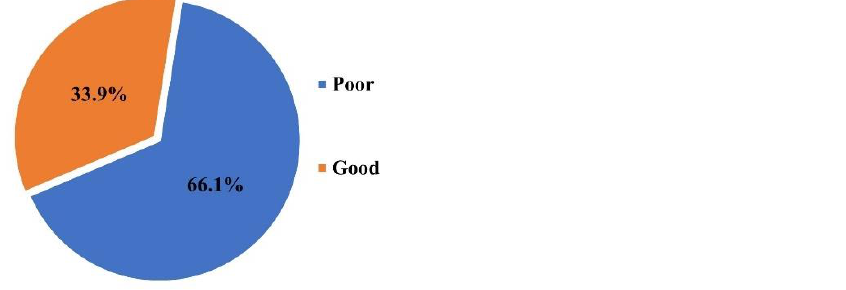
Table 3. Chi-square test results for analyzing association between mother s’ demographics and their adherence to HEP.